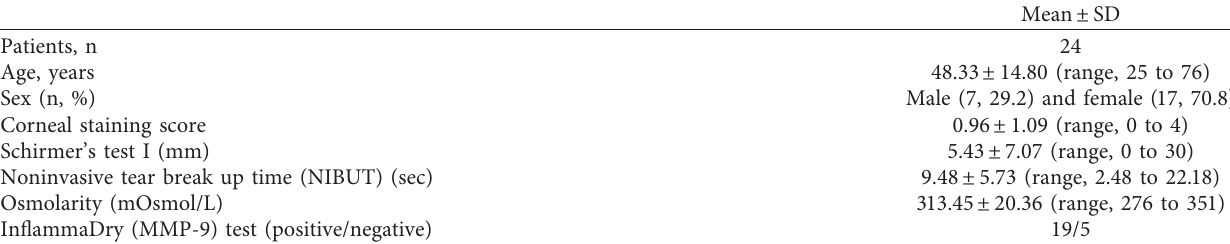
Table 1: Baseline characteristic of patients enrolled in the study.